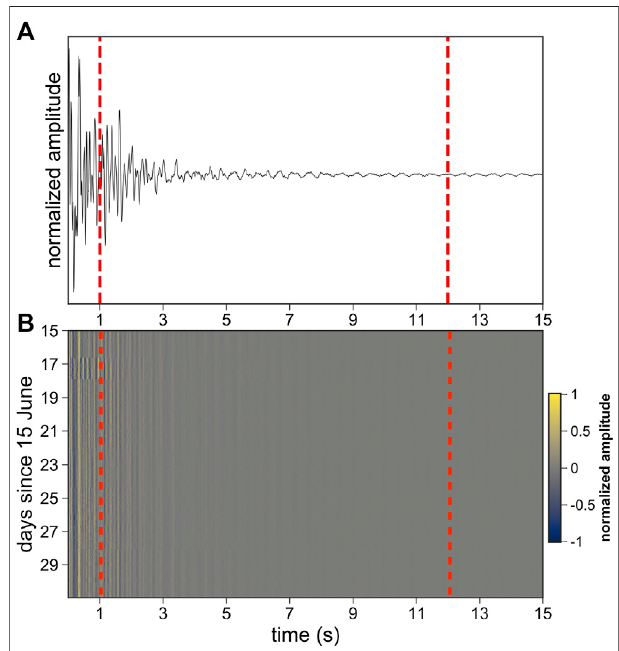
FIGURE 3 | (A) Reference trace averaged over all the correlograms. (B) HourlycorrelogramsfromJune15toJune30,2019,inthe2 – 20 Hzfrequency range. Vertical red dash lines mark the time window (1 – 12 s) of the coda used to estimate δ v / v .